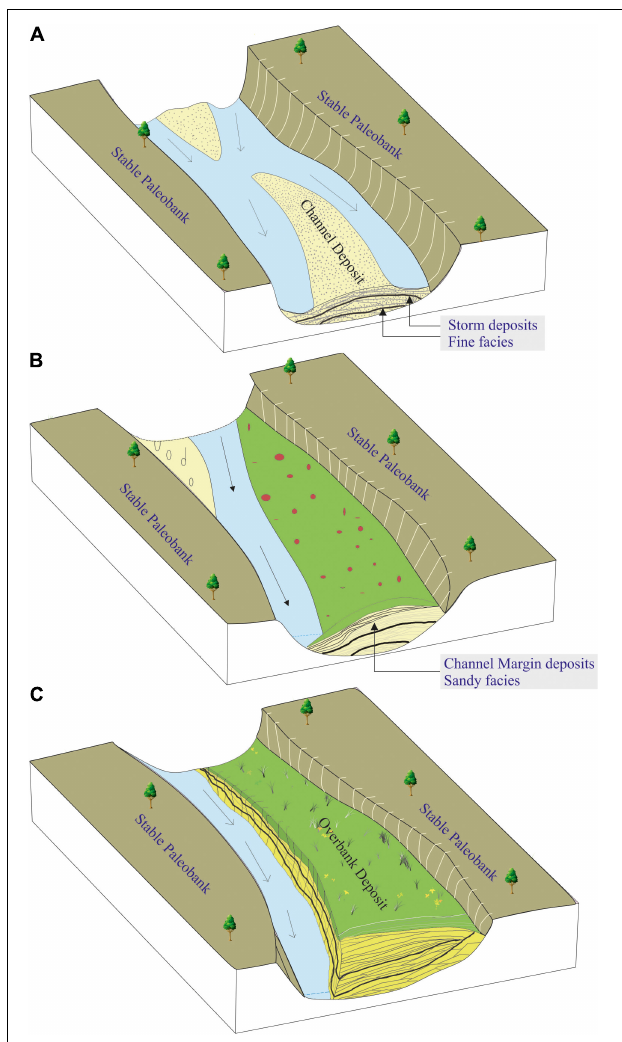
FIGURE 4 | A simplified depositional model of Neo-bank development. (A) Initiation and aggradation of bar within the channel due to large scale sand movement. (B) Stabilisation and merging of the bar with paleobank, sandwiching layers of fine-grained sediments deposited by monsoonal storm deposits, and finally giving way for development of overbank deposits. (C) Migration and fixing of the new channel, dominated by bank erosion and down